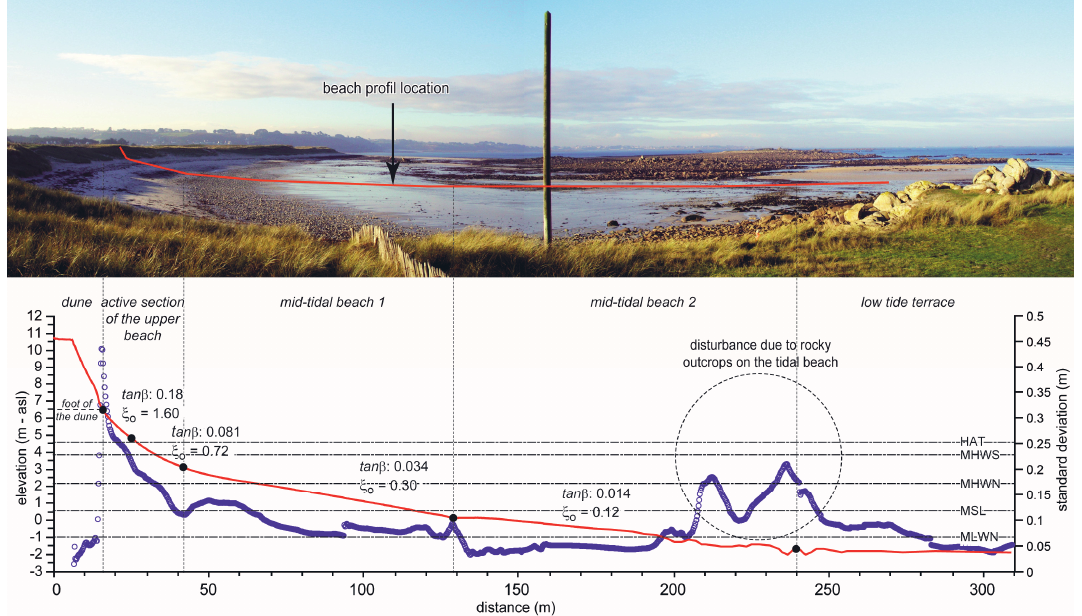
Figure 3. ( Red line ): Mean cross-shore profile of the surveyed Vougot beach section. ( Blue spot ): The standard deviation of profile elevation change rates (see Figure